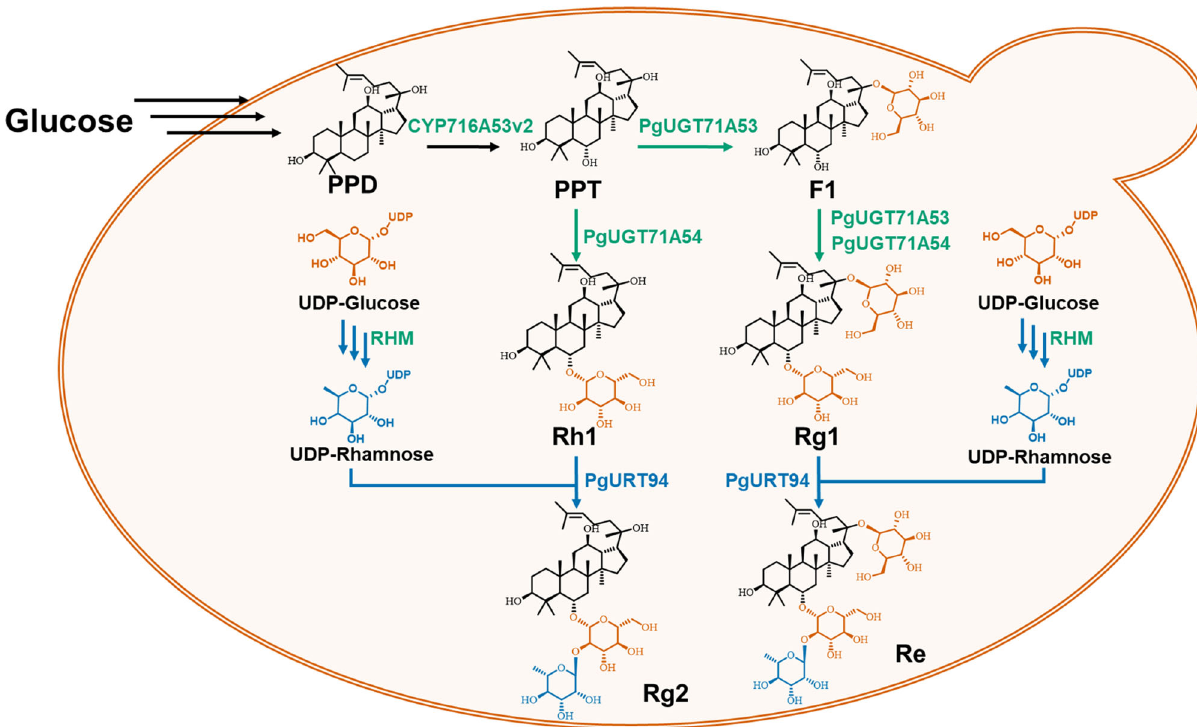
Fig. 1 The proposed pathway for de novo biosynthesis of ginsenosides Rg2 and Re in engineered yeast strains. Bluish green arrows represent glycosylation steps using UDP-glucose as a sugar donor, blue arrows represent the biosynthetic pathway of UDP-rhamnose and glycosylation steps using UDP-rhamnose as a sugar donor. Multi-step conversions were presented as multi arrows. Bluish green marked genes represented previous reported genes and the bule marked gene represented the identi fi ed one in this study. PPD protopanaxadiol, PPT